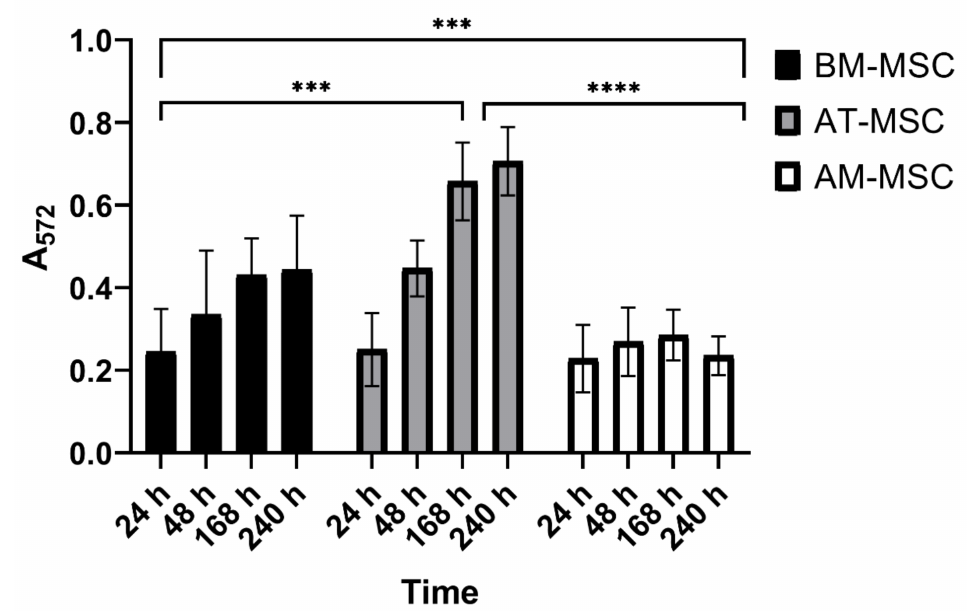
Figure 6. Results of the MTT assay. Graph representing absorbance measured after 24, 48, 168, and 240 h at 572 nm, which correlates with the proliferation capacity of examined types of MSCs. *** p = 0.0007 and **** p <